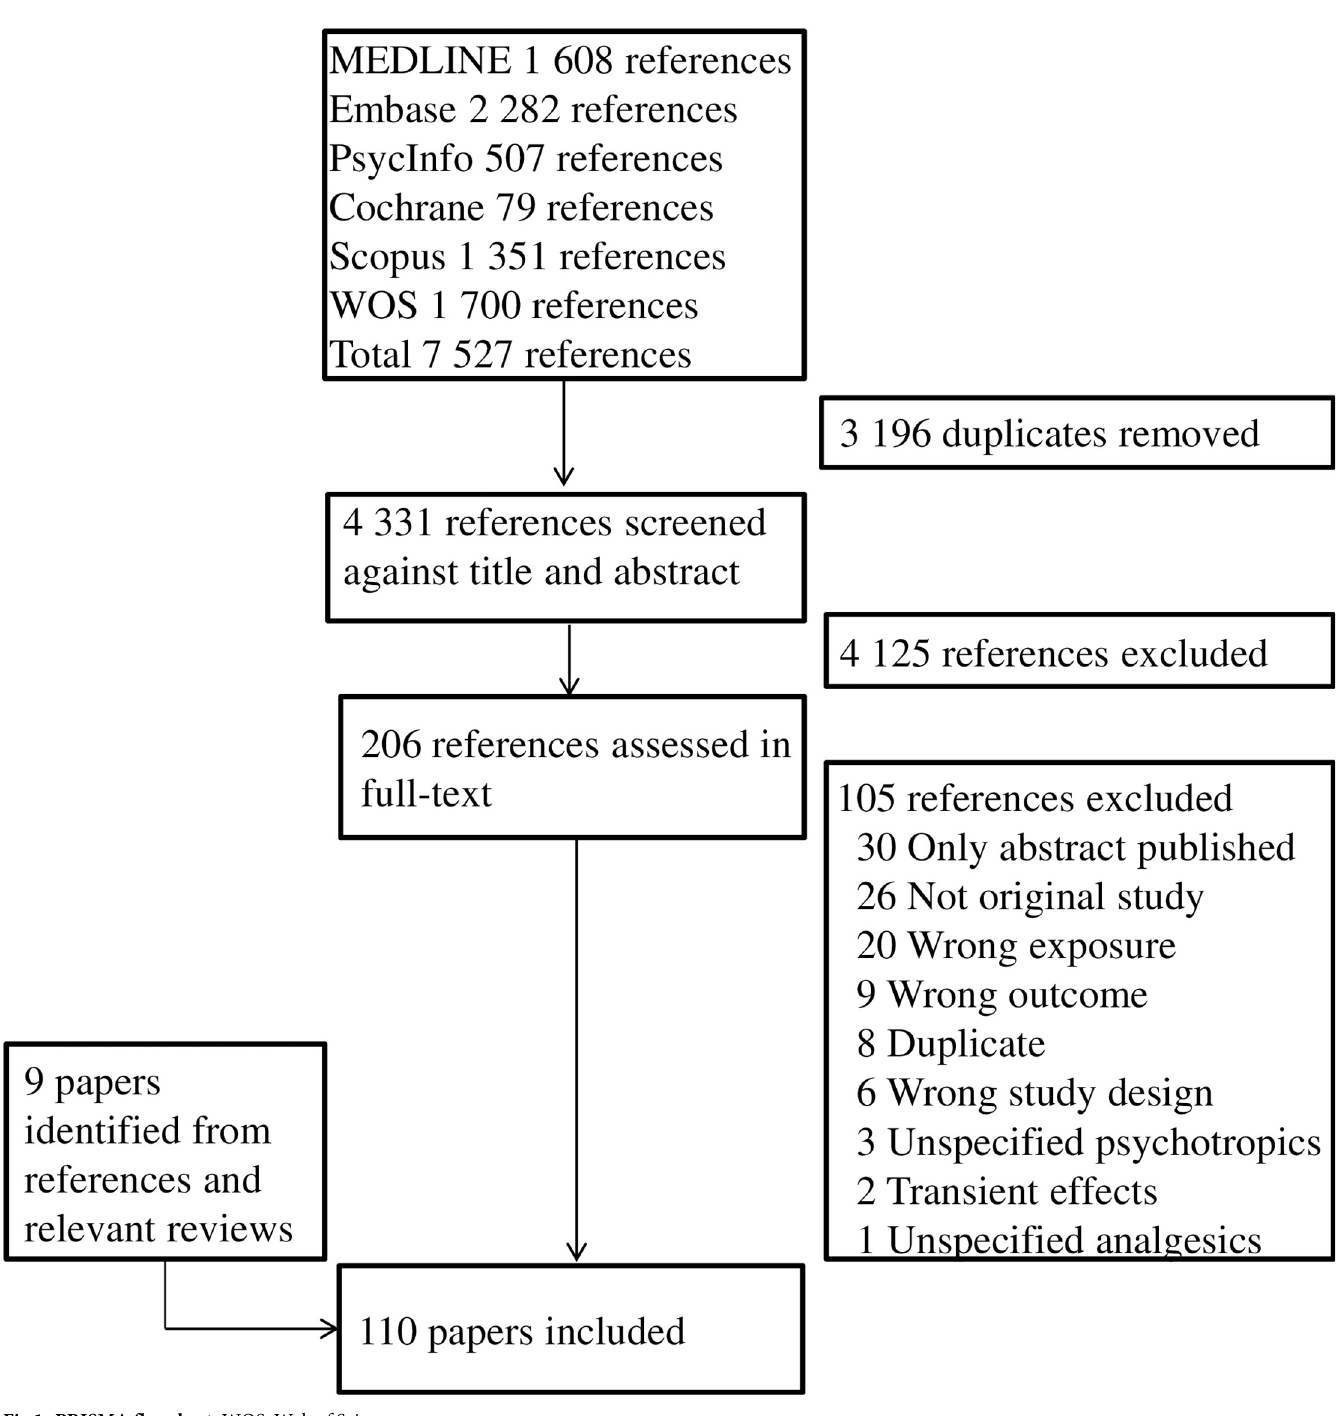
Fig 1. PRISMA flowchart. WOS: Web of